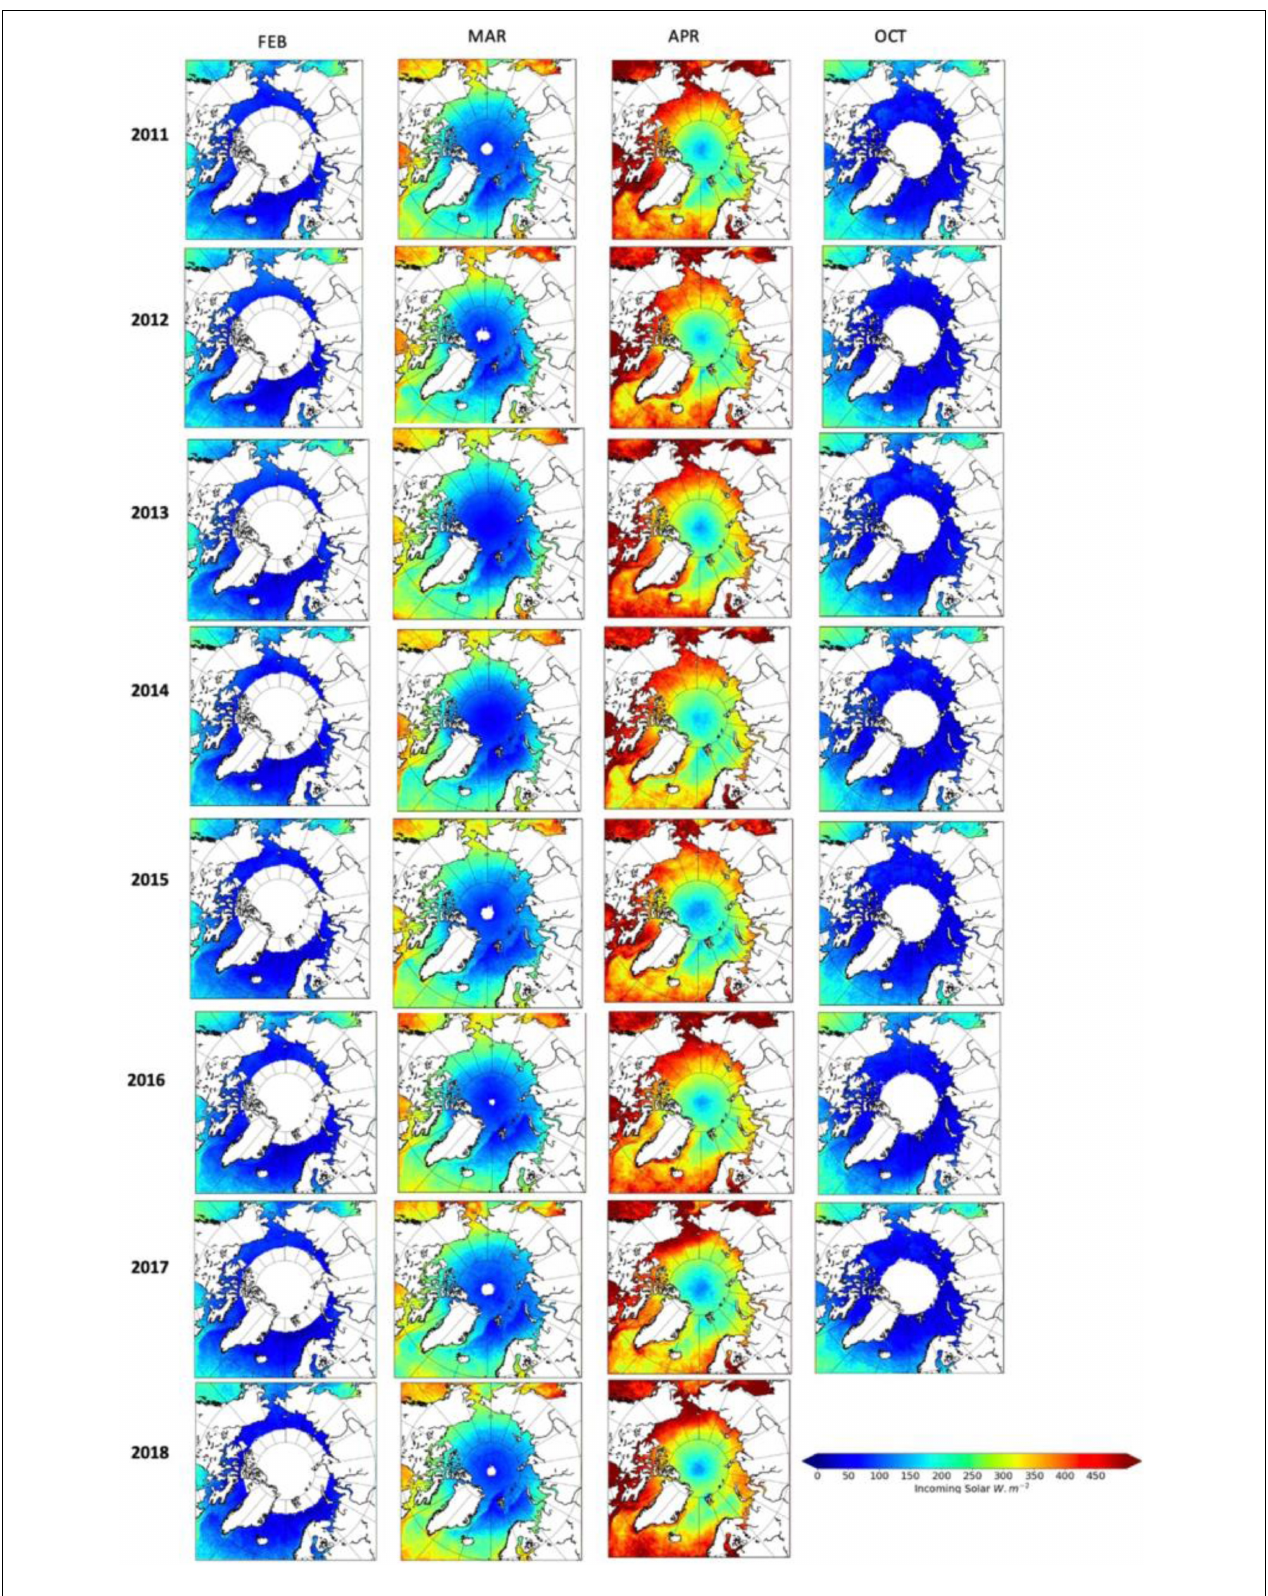
FIGURE 9 | Summary of the monthly mean incoming solar radiation for all months and all years from February 2011 to April 2018.